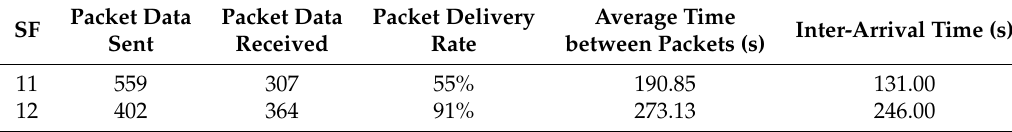
Table 2. Packet delivery rate and inter-arrival time metrics. SF, spreading